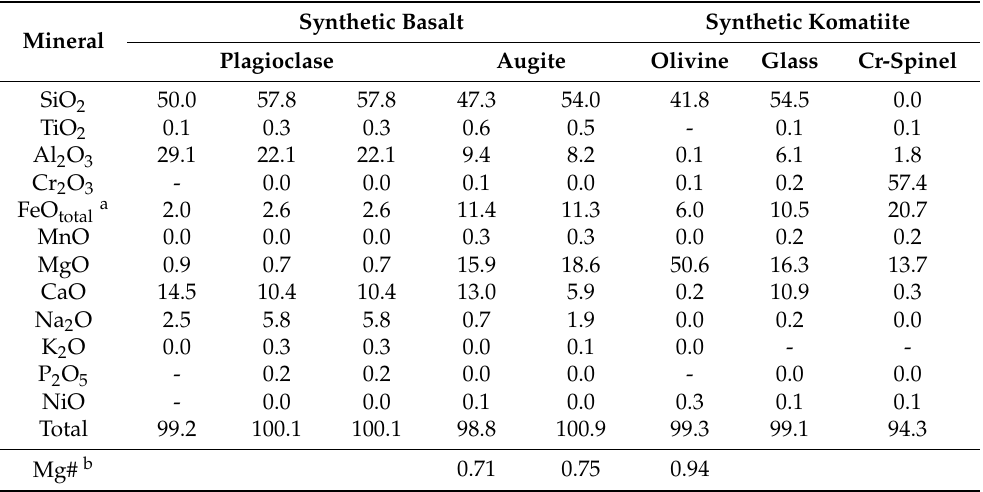
Table 2. Representative compositions of minerals (wt.%) in synthetic basalt and komatiite as deter- mined using